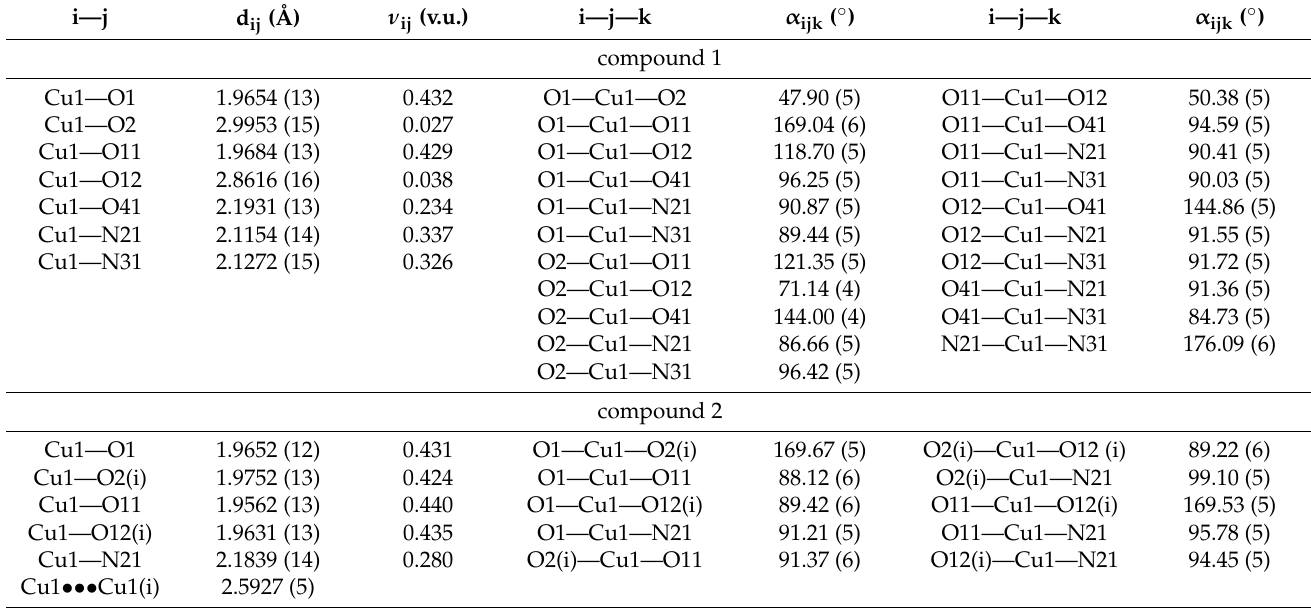
Figure 1. Molecular structure of 1, plotted with a 50% probability of displacement ellipsoids of nonhydrogen atoms and as spheres of arbitrary radii for hydrogen atoms ( a ). Coordination polyhedron of 1, general view ( b ), pentagonal base ( c ). Table 1. Structural data of the coordination polyhedra in the studied compounds.